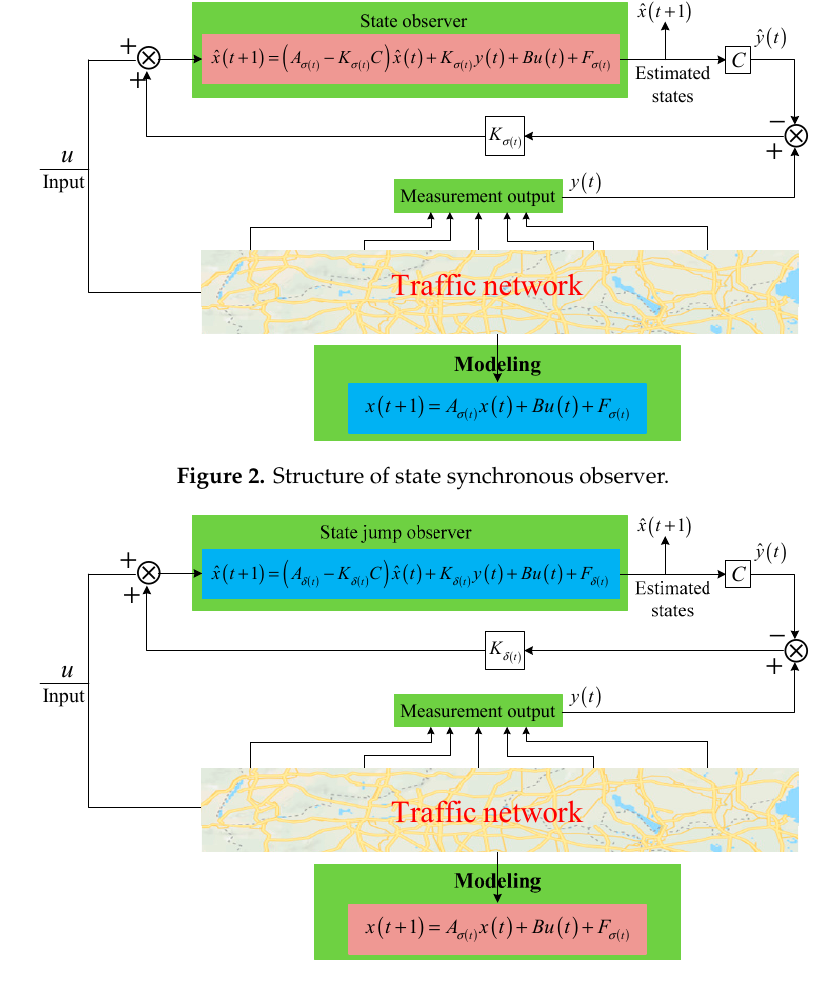
Figure 3. Structure of state jump observer.